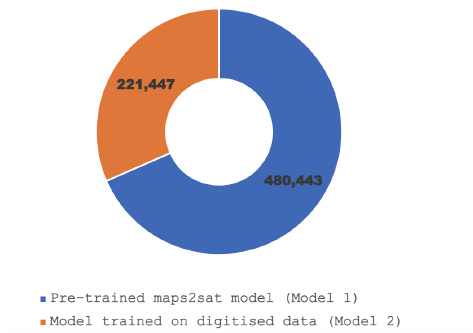
Figure 7. Model Evaluation: FID score